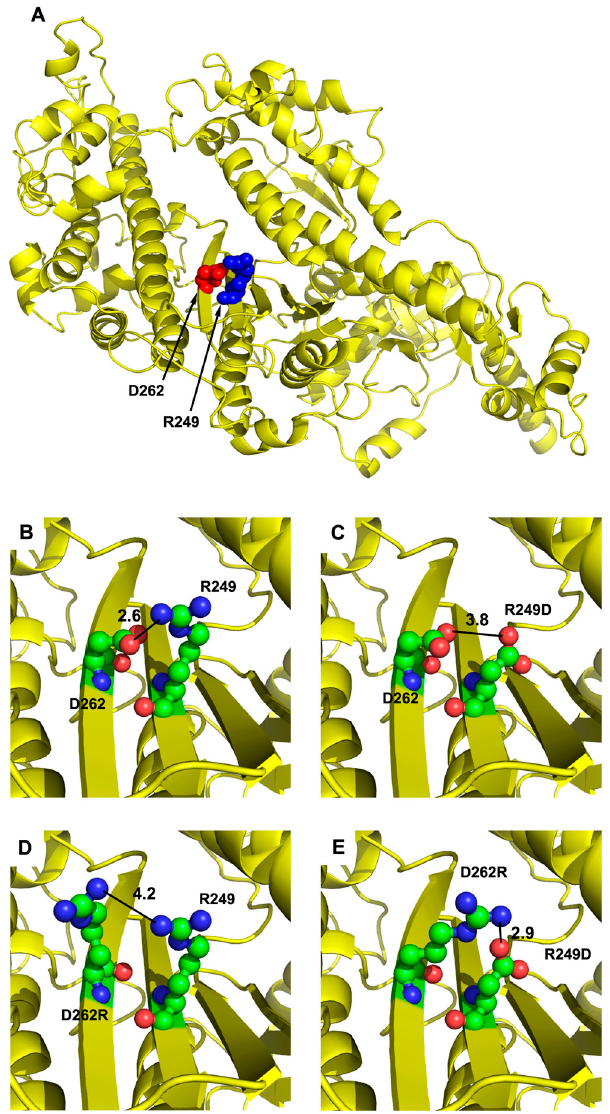
Figure 1. Location and interaction of transducer residues R249 and D262 on the myosin molecule. ( A ) The human β -cardiac myosin motor domain (PDB: 4P7H) was used as a template for modeling the Drosophila indirect flight muscle myosin heavy chain sequence to determine the location of R249 (displayed as blue spheres) and D262 (red spheres). The R249 residue is located on the sixth strand and D262 is located on the seventh strand of the central β -sheet that is a portion of the myosin transducer. ( B ) The positively charged R249 residue interacts with negatively charged D262, with a 2.6 Å contact distance. ( C ) The R249D mutation disrupts the charged interaction with D262 due to their opposing charges, yielding an increase in contact distance to 3.8 Å. ( D ) The D262R mutation disrupts the charged interaction with R249 due to their opposing charges, yielding an increase in contact distance to 4.2 Å. ( E ) The R249D-D262R double mutation reestablishes the charged interaction with a contact distance of 2.9 Å.